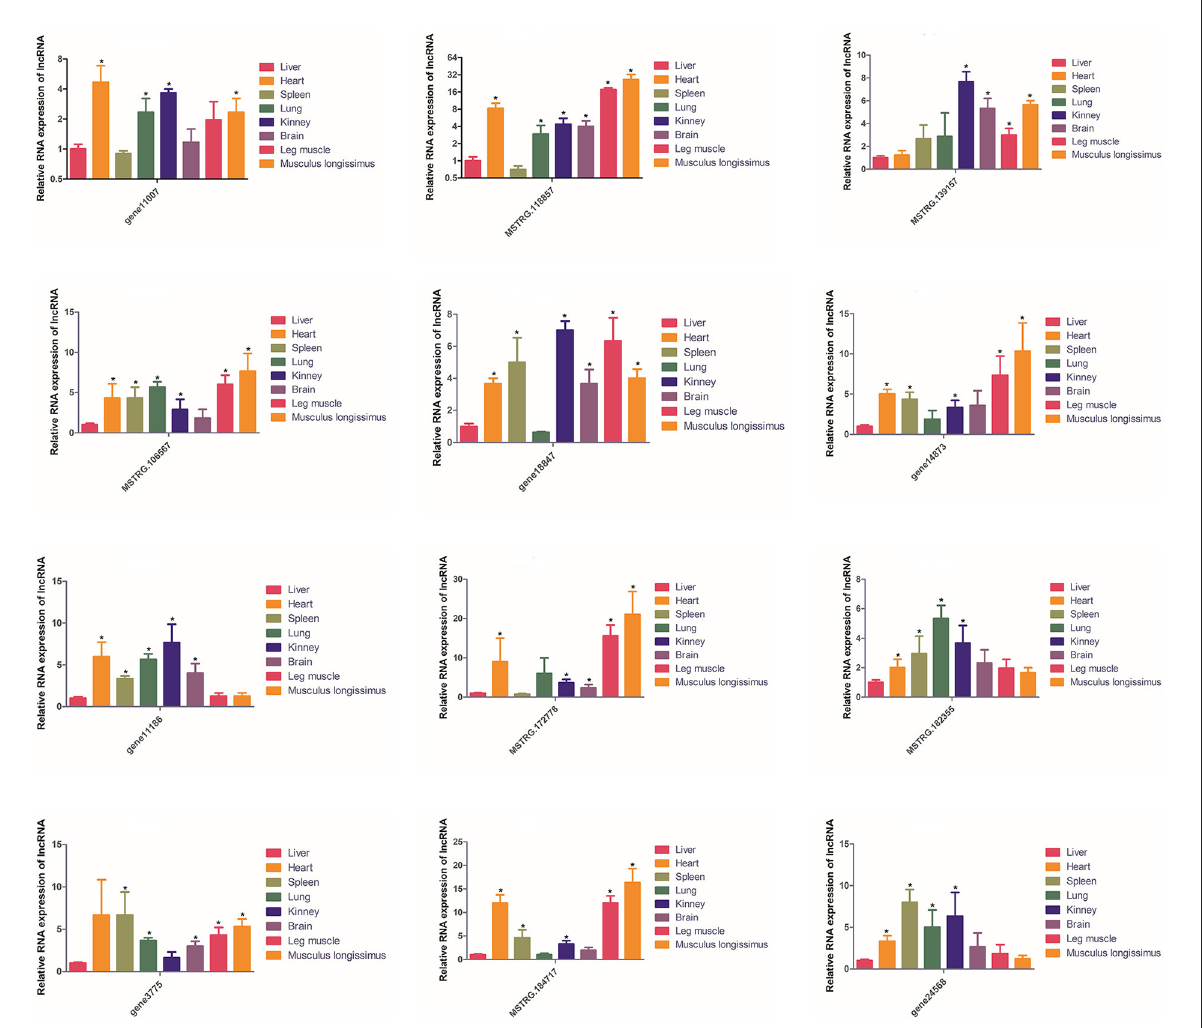
FIGURE7 Expression levels of 12 candidate lncRNAs in different tissues obtained from adult buffaloes. The values are means ± SEMs for three individuals. *represents P <